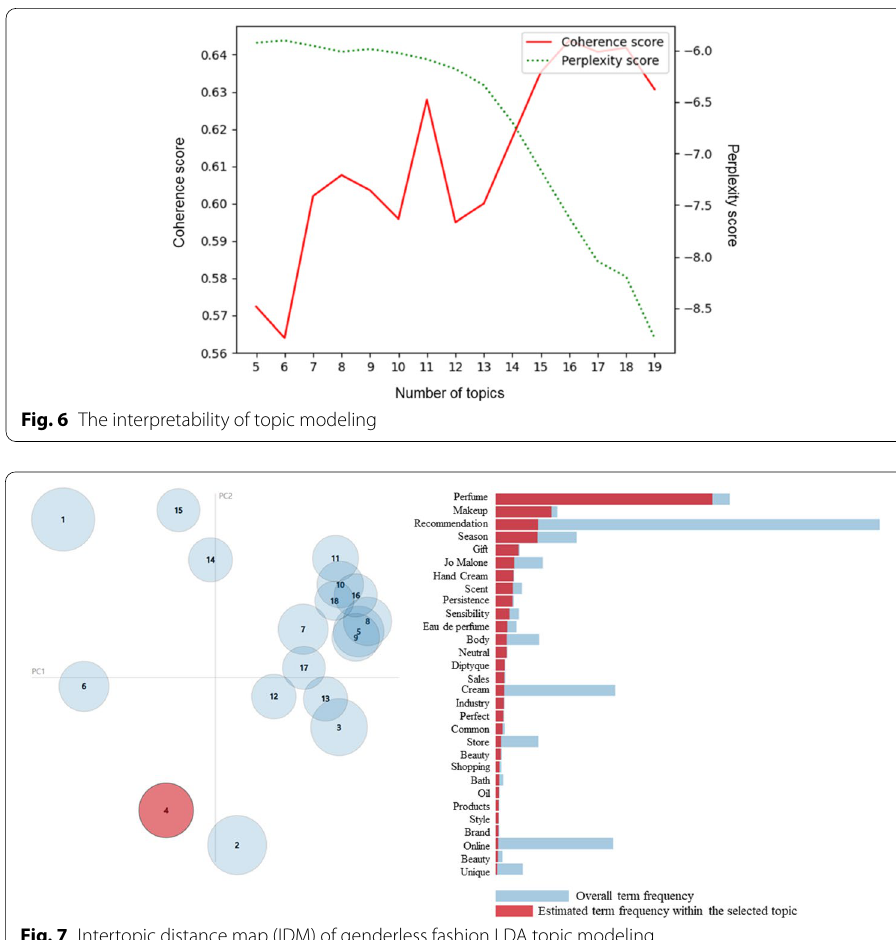
Fig. 7 Intertopic distance map (IDM) of genderless fashion LDA topic